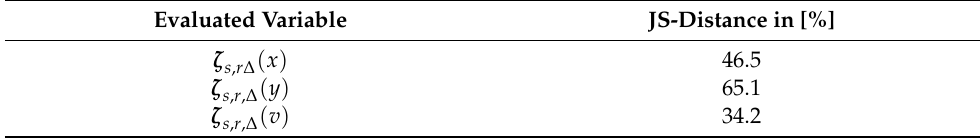
Table 3. The results for the far-range radar sensor, detection range 0 < x < 60 [m]. Evaluated Variable